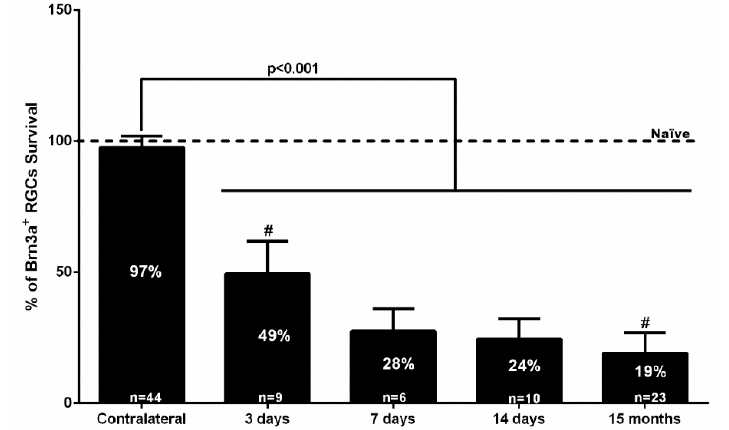
Figure 2. Bar graph showing the percent vs. intact retinas of the total numbers of Brn3a + RGCs ± standard deviation quantified in the contralateral uninjured and experimental retinas analyzed 3, 7, 14 days, or 15 months after the intraocular injection of 100 nM NMDA. The number of Brn3a + RGCs in the intact naïve retinas was considered 100%. The number of analyzed retinas is shown at the bottom of each bar. Statistically significant di ff erences were observed (Kruskal-Wallis test, p < 0.001) between values obtained in intact retinas (naïve) or right eye retinas (contralateral) and experimental retinas examined at 3, 7, 14 days, or 15 months. When compared with the previous time study interval (at 7 days, 14 days, or 15 months), there were no significant di ff erences (Kruskal-Wallis test, p > 0.05). However, there were significant di ff erences between 3 days and 15 months ( # Mann Whitney test, p = 0.019), but not from those obtained at 7 days (Mann Whitney test, p = 0.187), which suggests that NMDA-induced Brn3a + RGC loss does not progress between 7 days and 15 months. Table 1. Total numbers of Brn3a + RGCs in right (RE) or left (LE) eye retinas.